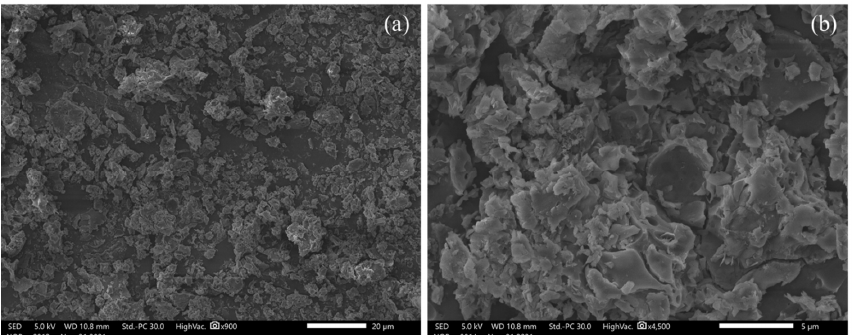
Figure 4. SEM micrographs of (FP-SAL/Lys-PA) NCs at ( a ) 900× magnification and ( b ) 4500× mag- nification, highlighting the aggregated nature of the NC. tion, highlighting the aggregated nature of the